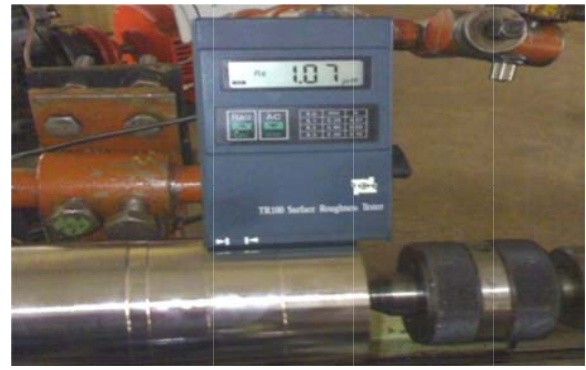
Figure 3. Experimental configuration for measuring surface roughness criteria.